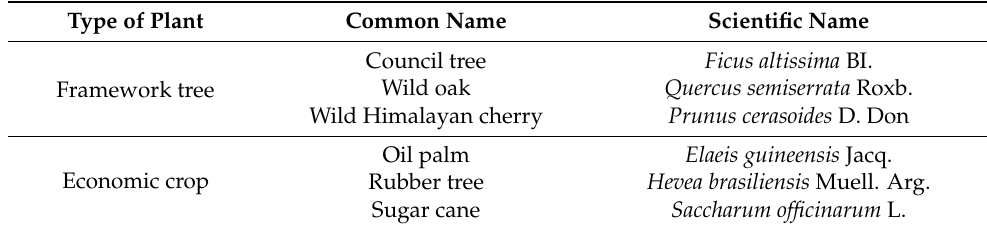
Table 1. Plant species and associated soils, selected for this